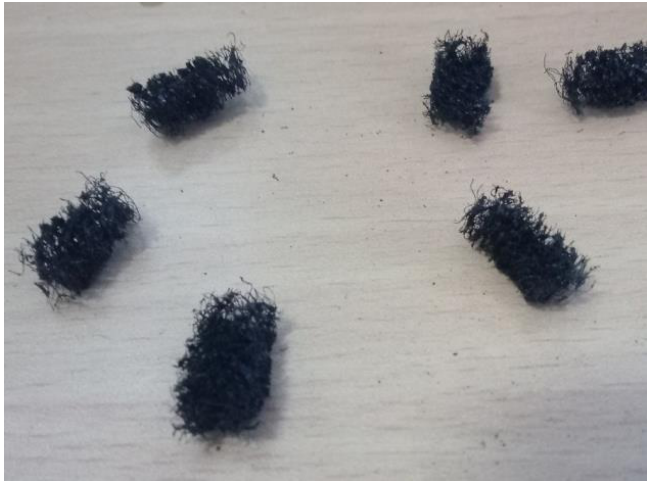
Figure 1. Porous sponge inserts.